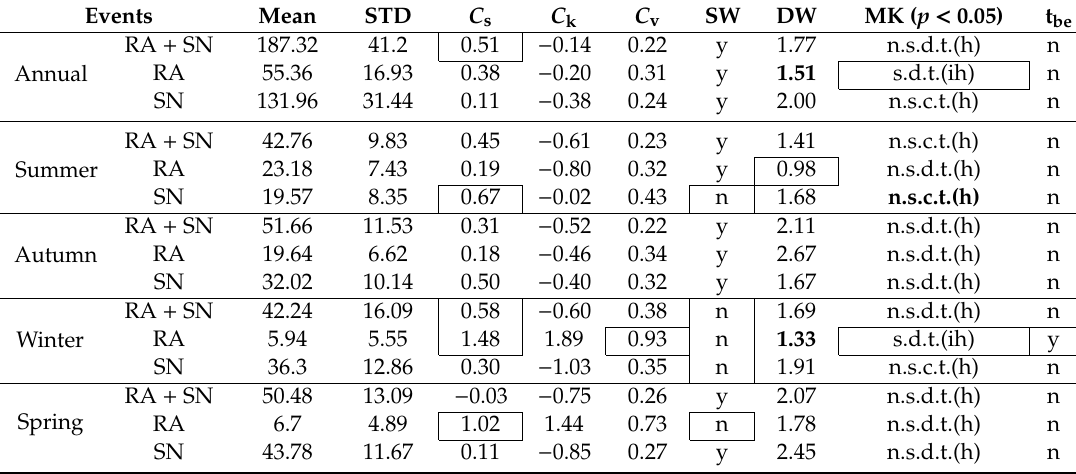
Table 1. Annual and seasonal mean and standard deviation of the events, along with the coe ffi cient of skewness ( C s ), kurtosis ( C k ), varied ( C v ), Shapiro–Wilk test (SW) for normal distribution, and the Durbin–Watson (DW) test autocorrelation. Enclosed numbers indicate when the parameter does not meet specified thresholds (see text). In column t be , n (y) indicates nonautocorrelation (correlation) (i.e., the null hypothesis was not (was) met). Bold numbers in DW column means that the results are uncertain. In column MK, n.s.d.t. (s.d.t.) means nonstatistical decreasing trend (statistical decreasing trend), while n.s.c.t. (s.c.t.) means nonstatistical creasing trend (statistical creasing trend). h (ih) means